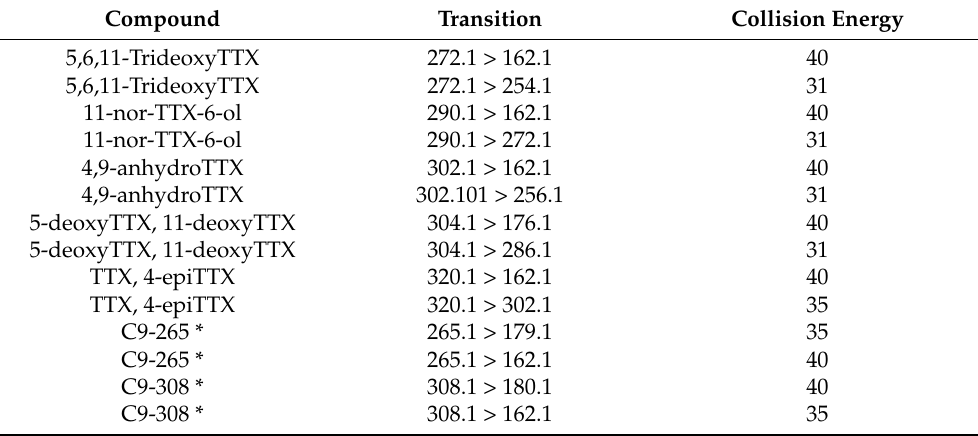
Table 1. Transitions used for TTX and their analogs.